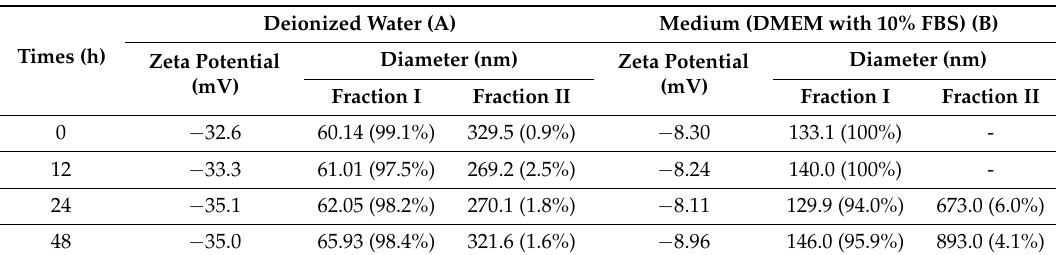
Table 1. Zeta potential and size of SiNPs in deionized water ( A ) or DMEM with 10% of FBS ( B ) as dispersion medium at different time points (at 37 ◦